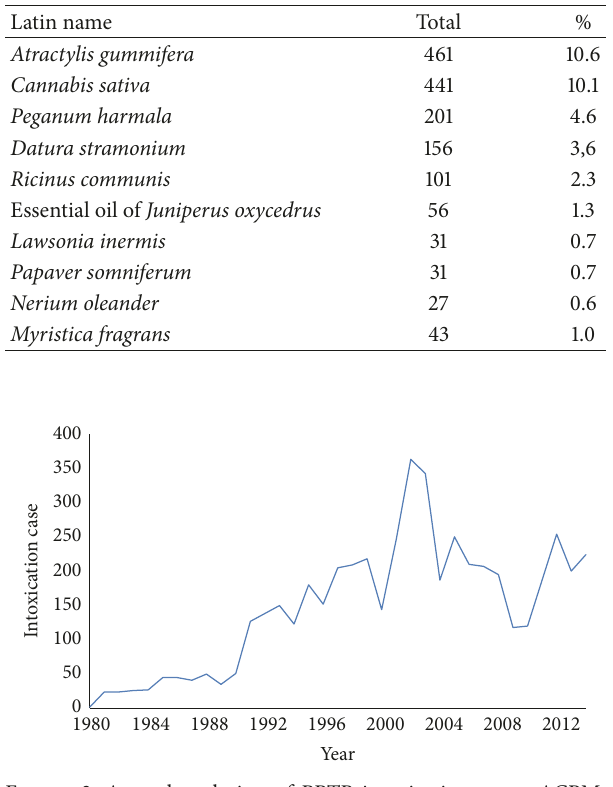
Table 1: Distribution of cases of poisoning by plants according to the species involved. Extracted from the global table of the ACPM,